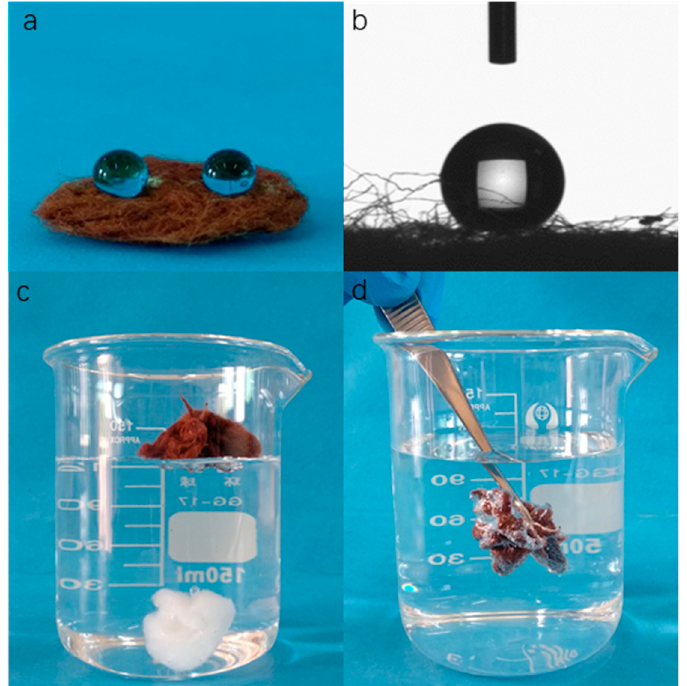
Figure 7. ( a ) Optical images of the water droplets on cotton@PVP@Fe 3 O 4 @FAS surface; ( b ) Shape of a